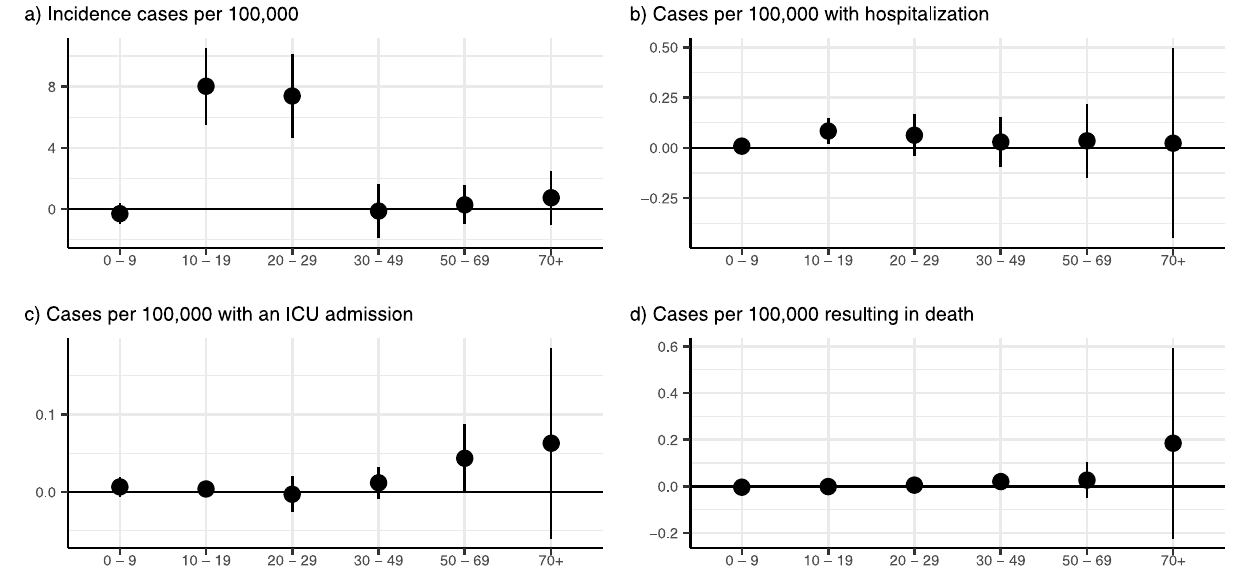
Fig 2. Age-specific effects of college reopenings. (a) demonstrates that the increase in the incidence of COVID-19 was isolated to people between 10 and 29 years of age, which encompasses most college-age individuals ( χ 2 (5) = 67.2, p < 0.001). In the aggregate, hospitalization rates did not change differentially by age after reopening (b; χ 2 (5) = 5.28, p = 0.382). Similarly, we find no evidence of differential changes in the incidence of cases requiring ICU admission (c; χ 2 (5) = 5.14, p = 0.398). We did not find any age-specific increases in mortality due to COVID-19, although these results were imprecisely estimated (d; χ 2 (5) = 7.57, p = 0.181). Figure plots point estimates and 95% confidence intervals. Point estimates and standard errors are available in S5